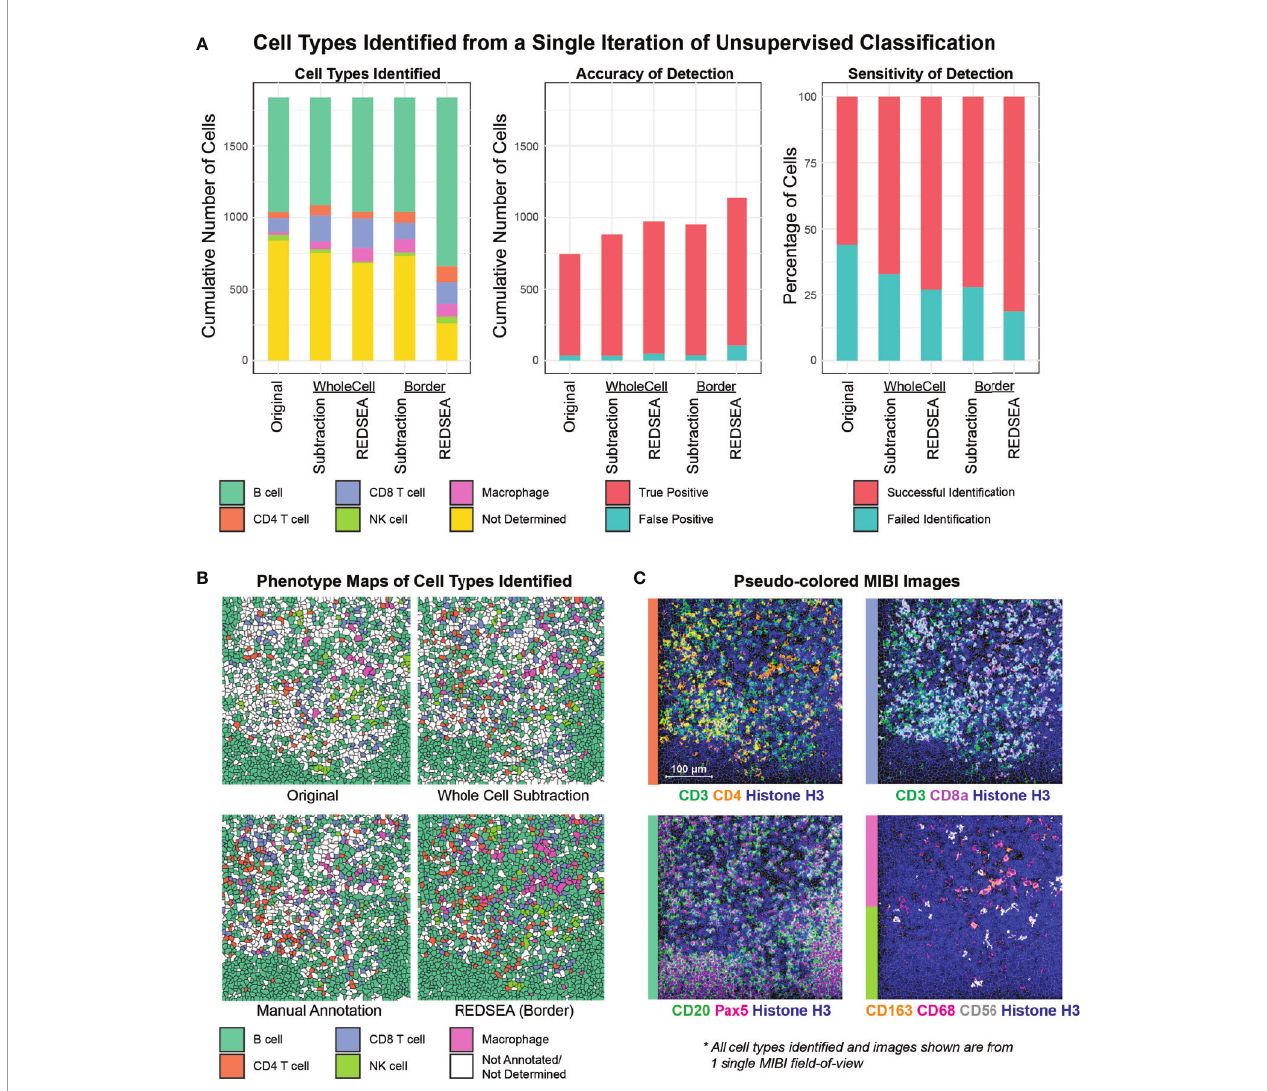
FIGURE 4 | REDSEA Improves Cell-type Annotation of MIBI images. (A) Single-cell marker values were determined from a single MIBI fi eld of view of a rhesus macaque lymph node (400 µm x 400 µm) with no corrections (Original) or 1) spillover subtraction on the whole cell, 2) REDSEA compensation on the whole cell, 3) spillover subtraction on only the border region and 4) REDSEA only on the border regions. A single iteration of unsupervised cell type classi fi cation was performed with identical parameters on extracted single cell marker values under each of the conditions. The quanti fi cation of cell types identi fi ed in terms of fold change (left) and cumulative number (right) are represented here. Not determined (yellow) denotes cell types that could not be con fi dently assigned to clusters identi fi ed during classi fi cation. (B) Spatial positions of cell types identi fi ed under each condition are represented as phenotype maps. Phenotype maps for cell types identi fi ed without correction (Original), with whole cell-based spillover subtraction (Whole Cell Subtraction), with consensus-based manual annotation from three independent individuals (Manual Annotation) and with border-based REDSEA [REDSEA (Border)] are shown. (C) Pseudo-colored MIBI images containing various combinations of cell-type-speci fi c markers from the same fi eld of